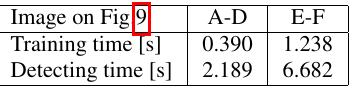
Table 2: The forest data, the comparison of the computation times for images on Fig. 9. A-D: MLM (cosine, variance, training set size 2500, R size 250). E-F: Piecewise MLM (cosine, variance, training set size 2500, R size